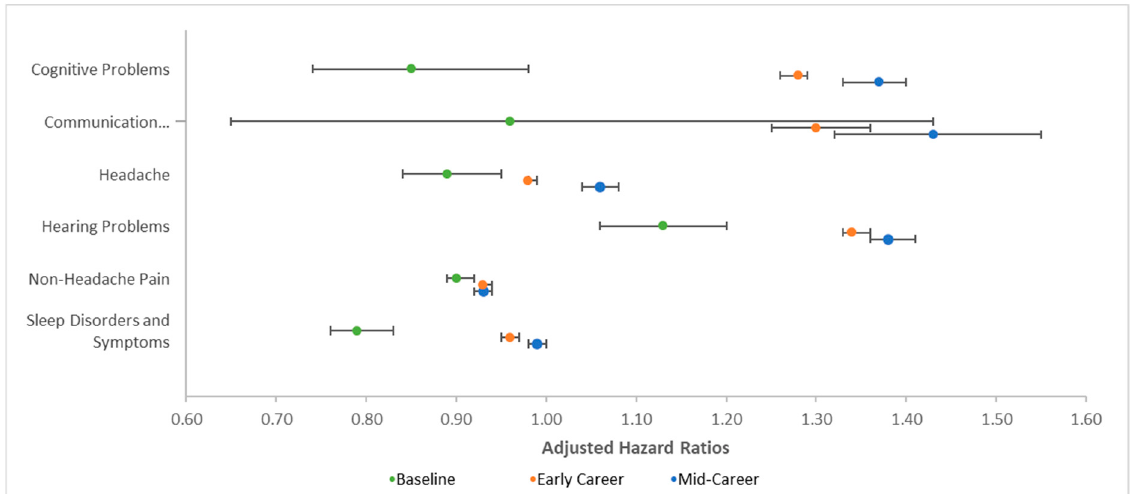
Figure 3. Graph of adjusted hazard ratios depicting decomposition of significant interaction between occupational risk of low-level blast (LLB) and time in risk for conditions commonly comorbid with mild traumatic brain injury. Adjusted hazard ratios represent the odds of being diagnosed with the conditions denoted as a function of occupational risk of LLB. Error bars represent 95% confidence intervals; all error bars are included, but some are not visually apparent because they are so close to the point estimate (e.g., lower bound for headaches).